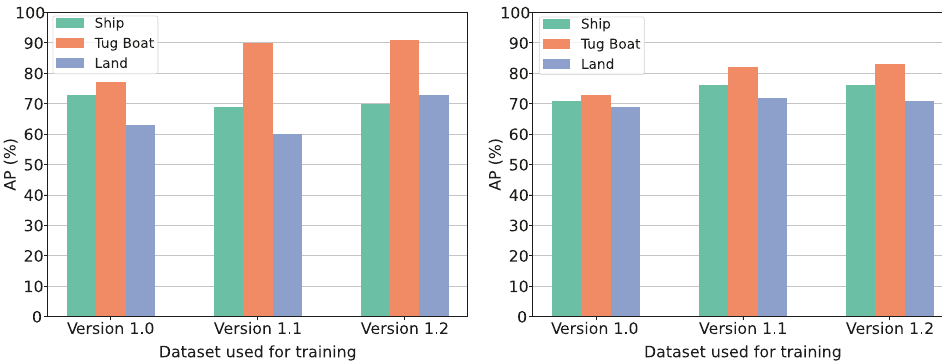
Figure 17. ( Left ) AP for bounding boxes for each category and dataset version. ( Right ) AP for segmentation for each category and dataset version.